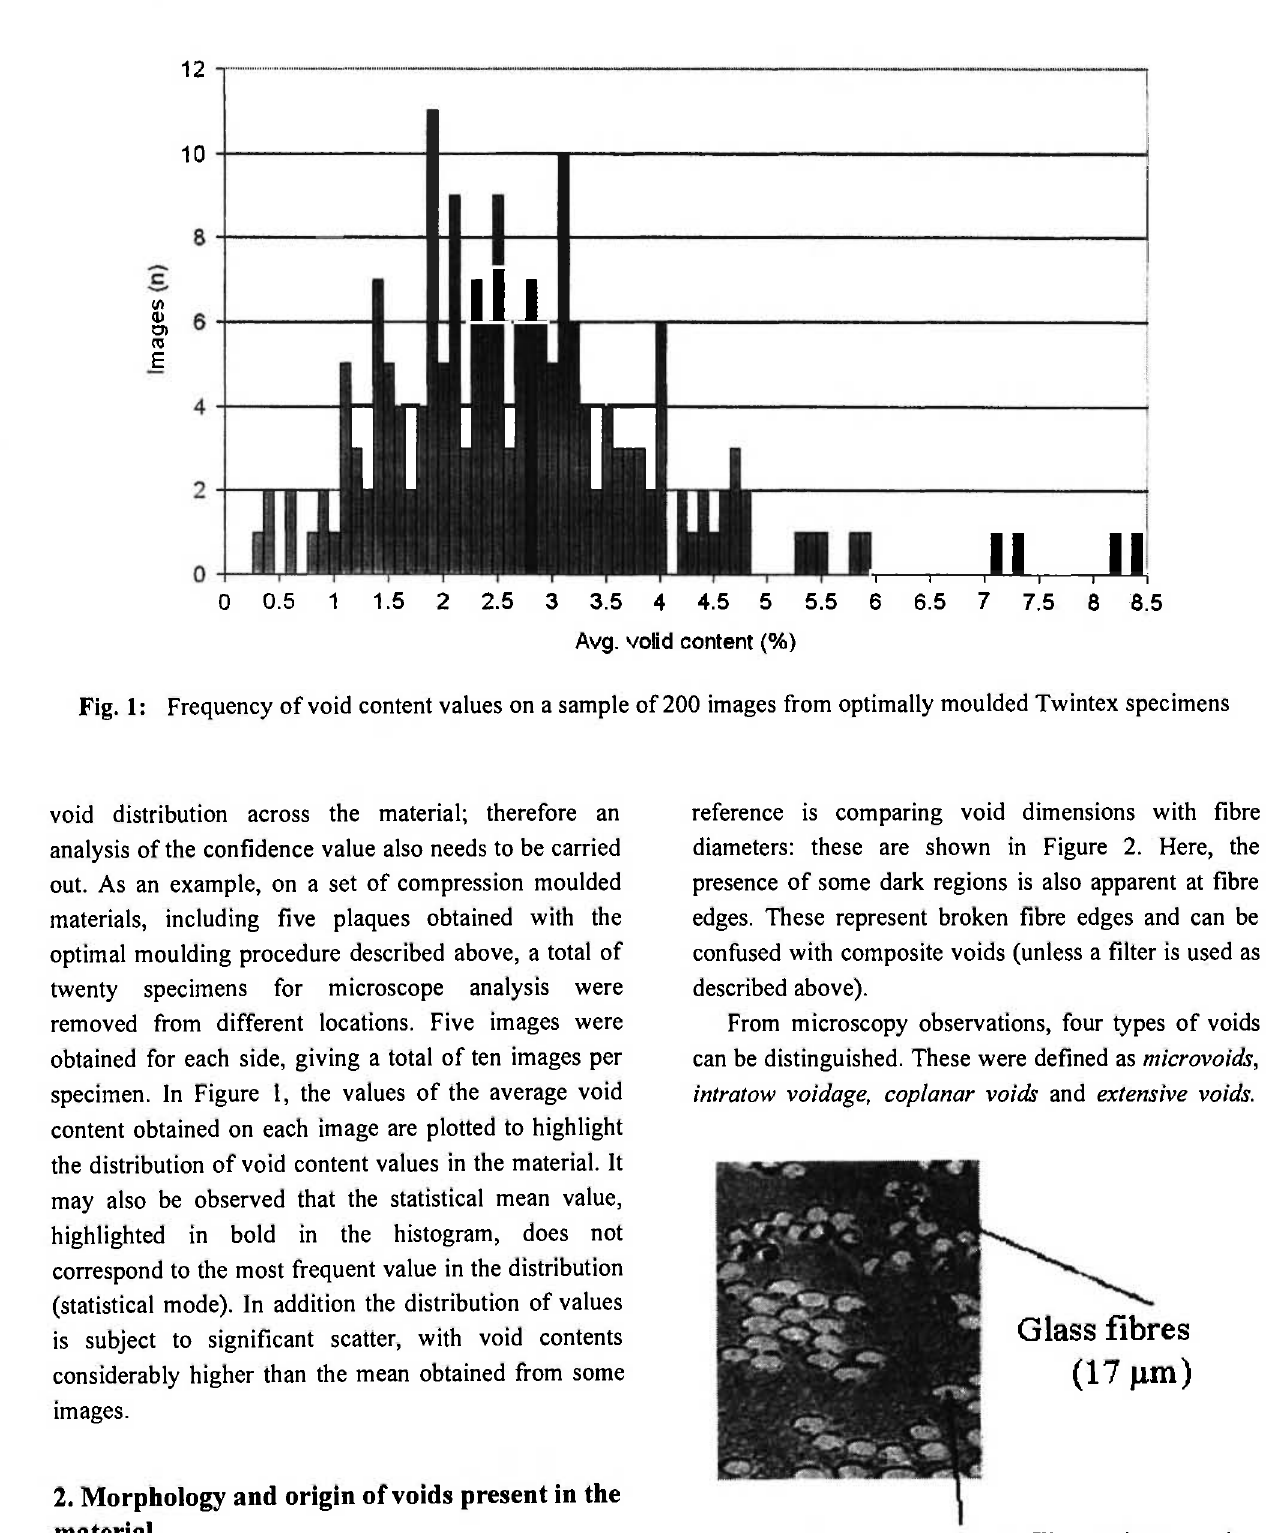
Fig. 2: Polypropylene and glass